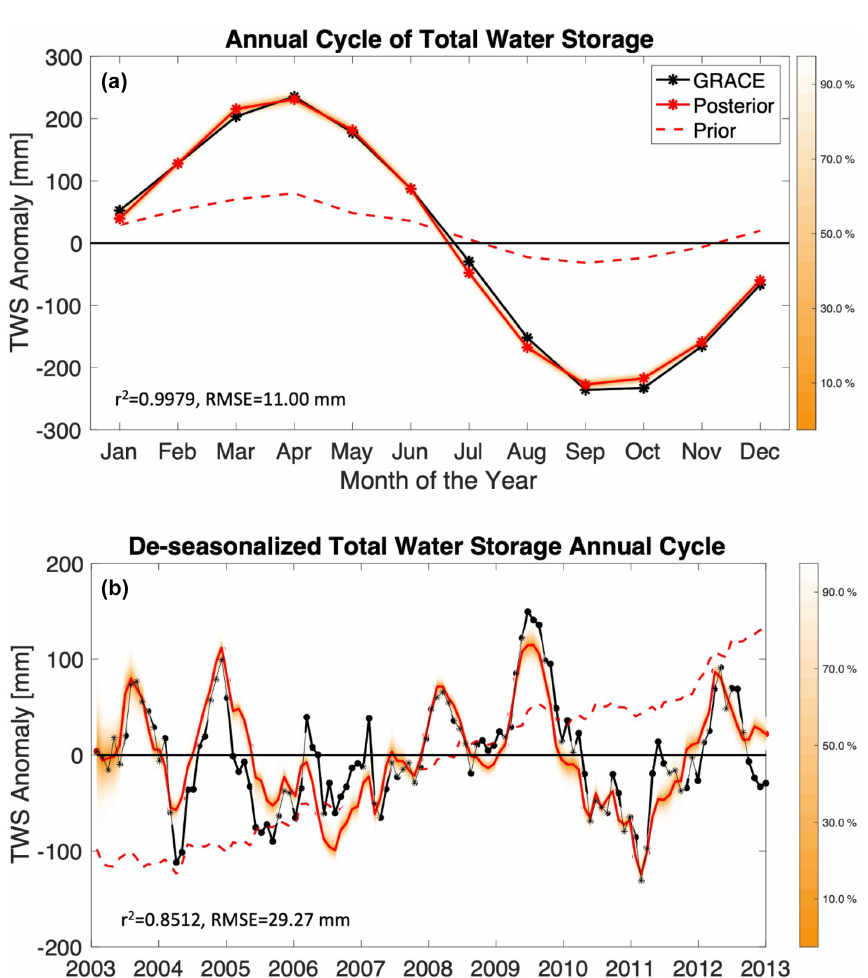
Figure 7. (a) Annual cycle of the monthly TWS anomalies [mm], from satellite data (GRACE), the prior simulation from the model (Prior), and the data-constrained version of the model simulations (Posterior) for the Gavião watershed. GRACE-informed posterior ranges of the model-simulated TWS annual cycle are shown here in the orange envelopes. (b) To obtain the de-seasonalized values of TWS for the Gavião watershed shown in panel (b) , we subtract the annual cycle in panel (a) from each month’s estimate shown in Fig. 4. This shows whether the anomaly values in each time step of panel (b) portrays an extremely dry or wet period relative to what is expected in the annual cycle. Hence, the data-constrained model can capture the 2005–2006 and 2010–2011 droughts that are shown in the GRACE